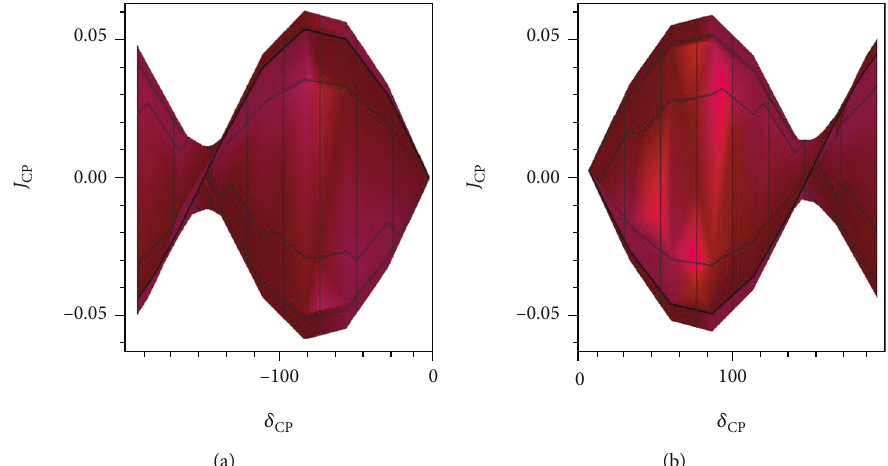
Figure 7: Predictions in the broken μ − τ symmetry model for normal ordering: (b) shows the allowed two-dimensional space of the Þ plane for an absolute range of δ ð δ , J CP CP